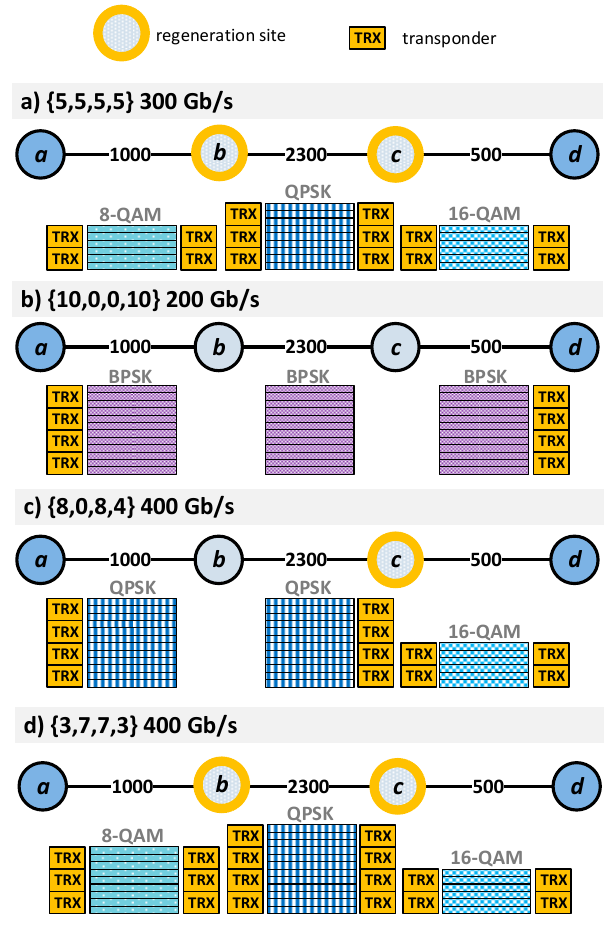
Figure 2. Example of different transponder placement scenarios for provisioning a request: a) placement of transponders in network nodes: {5, 5, 5, 5}; b) placement of transponders in network nodes: {10, 0, 0, 10}; c) placement of transponders in network nodes: {8, 0, 8, 4}; d) placement of transponders in network nodes: {3, 7, 7, 3}. Table 1. Transmission reaches (km) and supported bit rates (Gb / s) per one transponder for considered modulation